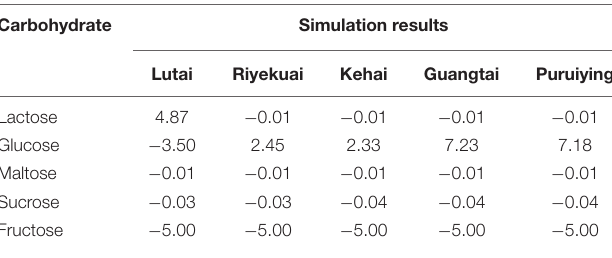
TABLE 8 | The simulation results of the requirements for carbohydrates in L. vannamei.